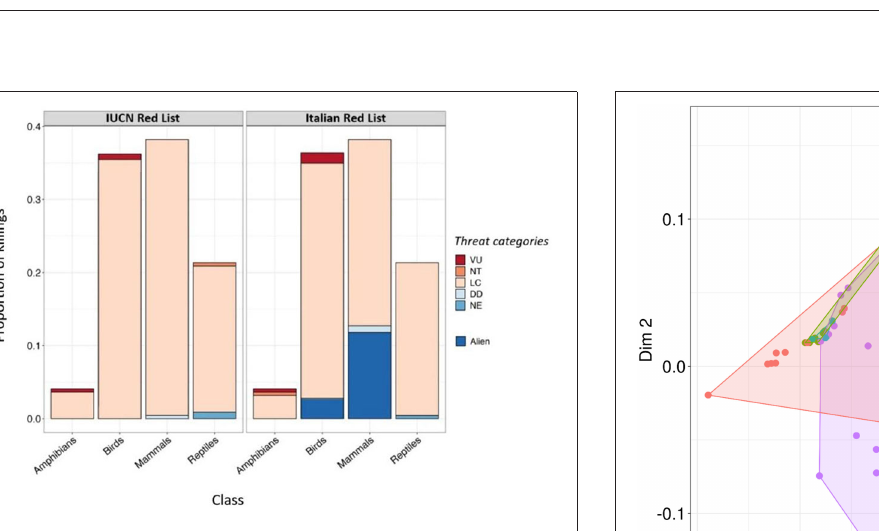
When examining the diet in functional trait space, PCoA analysis revealed that the class occupying the largest functional space was birds, followed by mammals, reptiles, and amphibians ( Figure 5 ). Therefore, the largest impact was on the functional structure of mammal and bird